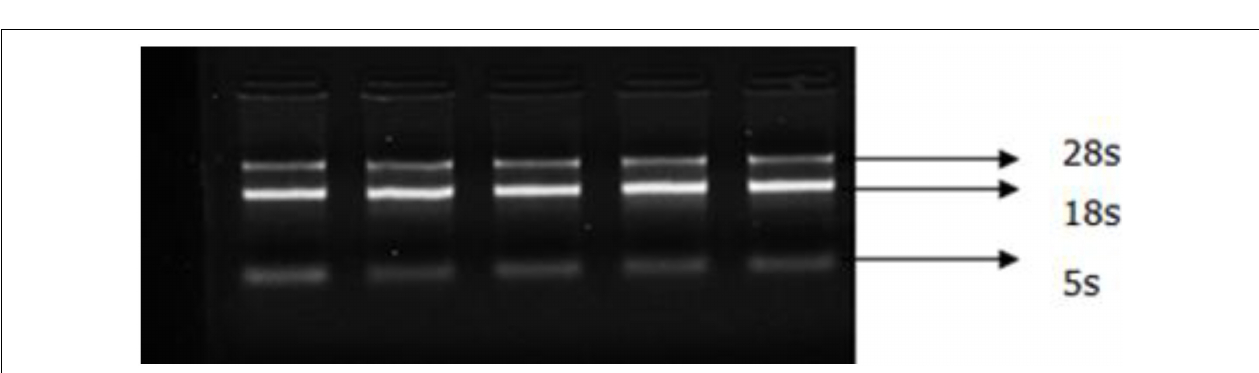
FIGURE 7 | Electrophoretogram of skin total RNA. Total RNA was extracted from skin samples and detected using the NanoDrop 2000 UV spectrophotometer (Thermo Fisher). Od260/280 values were all between 1.8 and 2.0. The bands with clear integrity of 28s and 18s were detected by 1% agarose gel